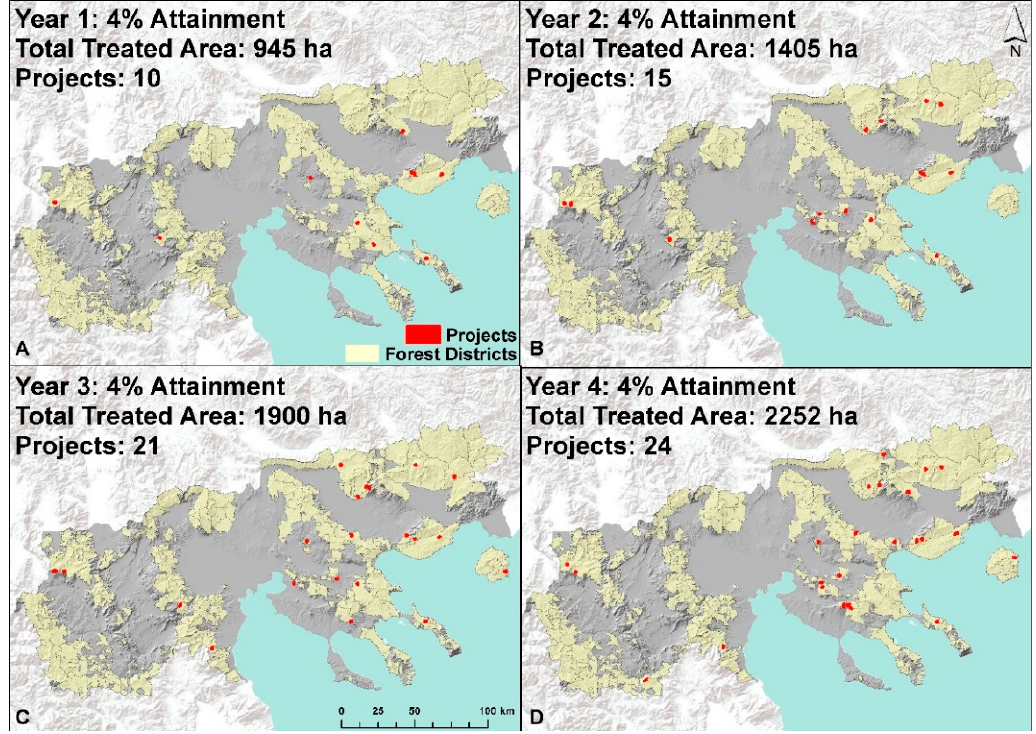
Figure A5. Annual fuel treatment locations of the best 100-hectare projects for a four-year management plan, as estimated from the prioritization of wildfire transmission to protected areas.